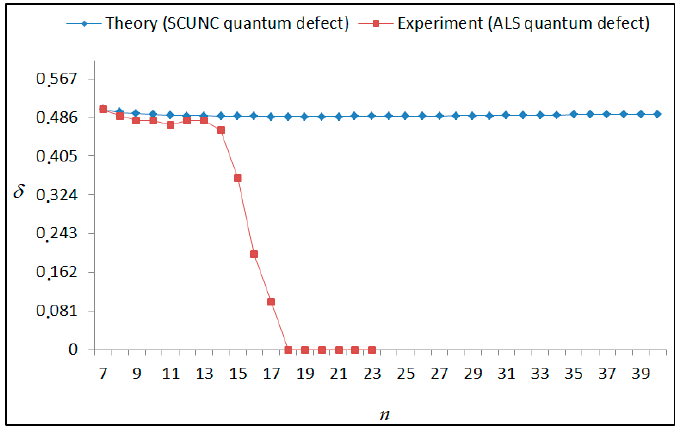
Figure 19. Variations of the quantum defect ( δ ) with the principal quantum number n for the 4 s 2 4 p 2 ( 1 D 2 ) ns ( 2 D ) Rydberg series originating from the 2 D ° 5/2 metastable state of Se + converging to the 1 D 2 series limits in Se 2+ .